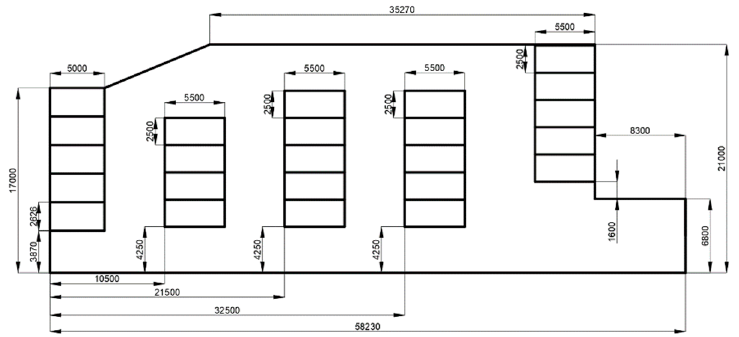
Figure 5. Parking lot map.